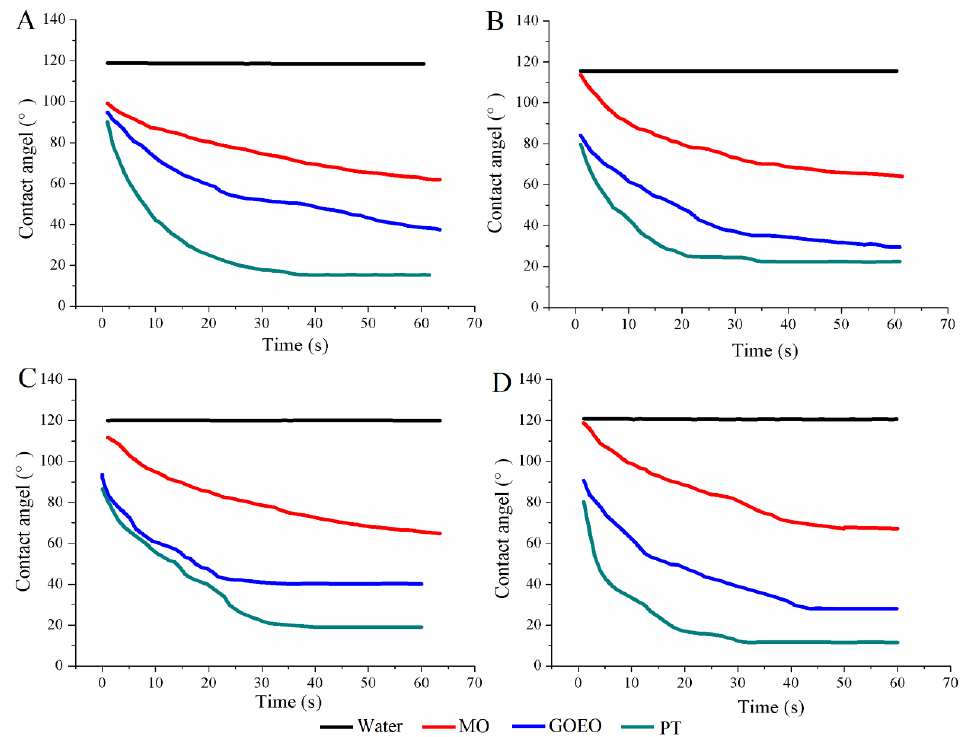
Figure 2. Contact angles of pesticide solutions with different spray adjuvants: ( A ) EPX at 125 mg/L, ( B ) EPX at 187 mg/L, ( C ) CLR at 66.7 mg/L, and ( D ) CLR at 100 mg/L.